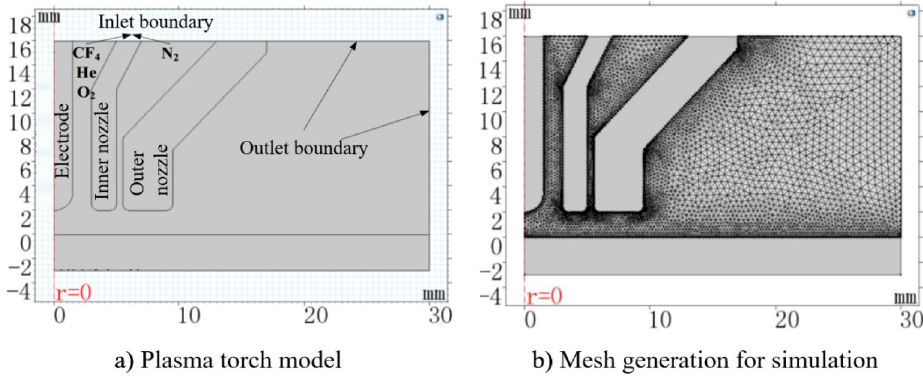
Figure 3. Simulation model of APPS plasma torch and its mesh generation.